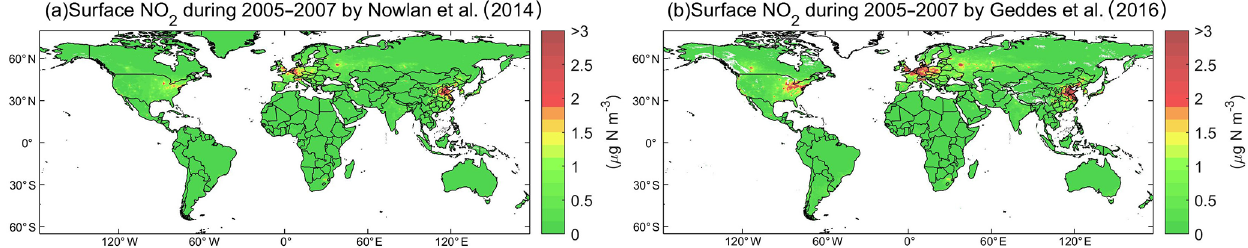
Figure 2. Satellite-derived surface NO 2 concentration during 2005–2007 by Nowlan et al. (2014) (a) and by Geddes et al. (2016) (b) . We gained the surface NO 2 concentration by Nowlan et al. (2014) and by Geddes et al. (2016) at the website: http://fizz.phys.dal.ca/~atmos/ martin/?page_id=232, last access: 17 July 2020.